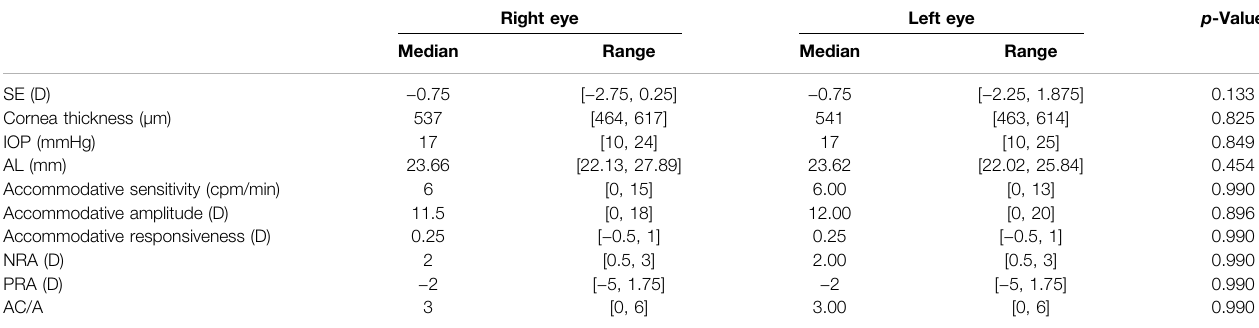
TABLE 1 | Baseline biometric parameters of both eyes before instillation of 0.01% atropine eye drops.